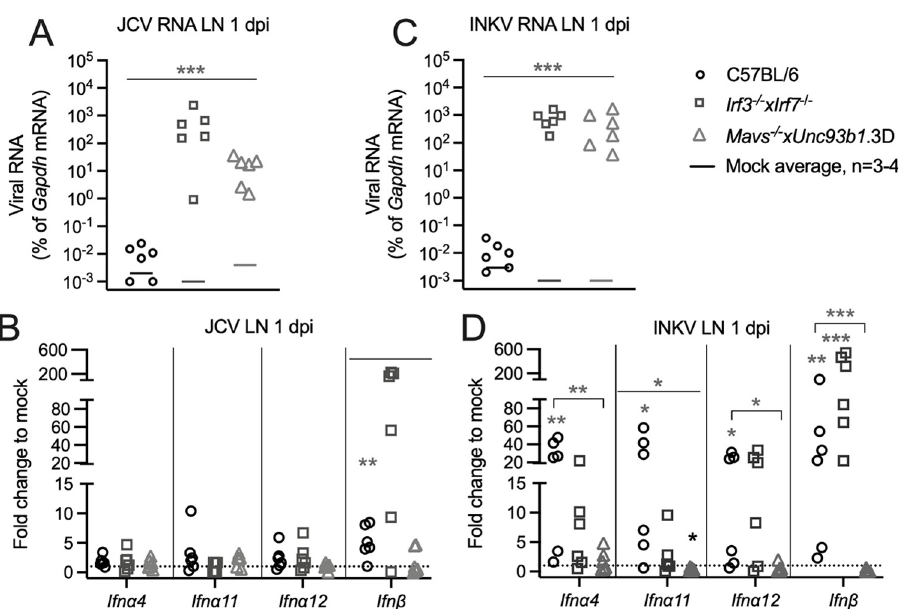
Fig 8. Comparison of the IFN mRNA response in LN at 1 dpi of wild type C57BL/6 mice and immune deficient DKO mice. Viral RNA was compared in the lymph nodes (LN) at 1 dpi of mice inoculated with JCV (A) or INKV (C). B,D) IFN mRNA expression was evaluated via RT-qPCR in LN at 1 dpi of JCV-inoculated mice (B) or INKV- inoculated mice (D) in B6 and DKO mice. A,C) One-way ANOVA was performed for each tissue on Log2(%gapdh) values and Dunnett’s multiple comparisons test done between B6 and DKO mice. Asterisks represent significant ANOVA and multiple comparisons p-values. B, D) There were significantly different levels in some basal Ifn expression between mock-inoculated B6 and DKO mouse strains, therefore Log2(fold change in %gapdh from mock) values were used to normalize expression to mock for analyses. One-sample t tests were done to analyze if the expression for each mouse strain and Ifn was significantly different from 0 (equivalent to fold change = 1 = mock). One-way ANOVA with Dunnett’s multiple comparison test between mock and the DKO strains was then run. Asterisks below the lines represent expression significantly different from mock (gray = significantly higher, black = significantly lower), and asterisks above the line represent a significant difference between B6 and one (bracketed) or both (flat line) DKO strains. Asterisks denote � p = 0.05–0.01, �� p = 0.009–0.001, ��� p � 0.0009, and values for the multiple comparisons are reported as the higher value from the two DKO strains. Dotted lines indicate fold change to mock =